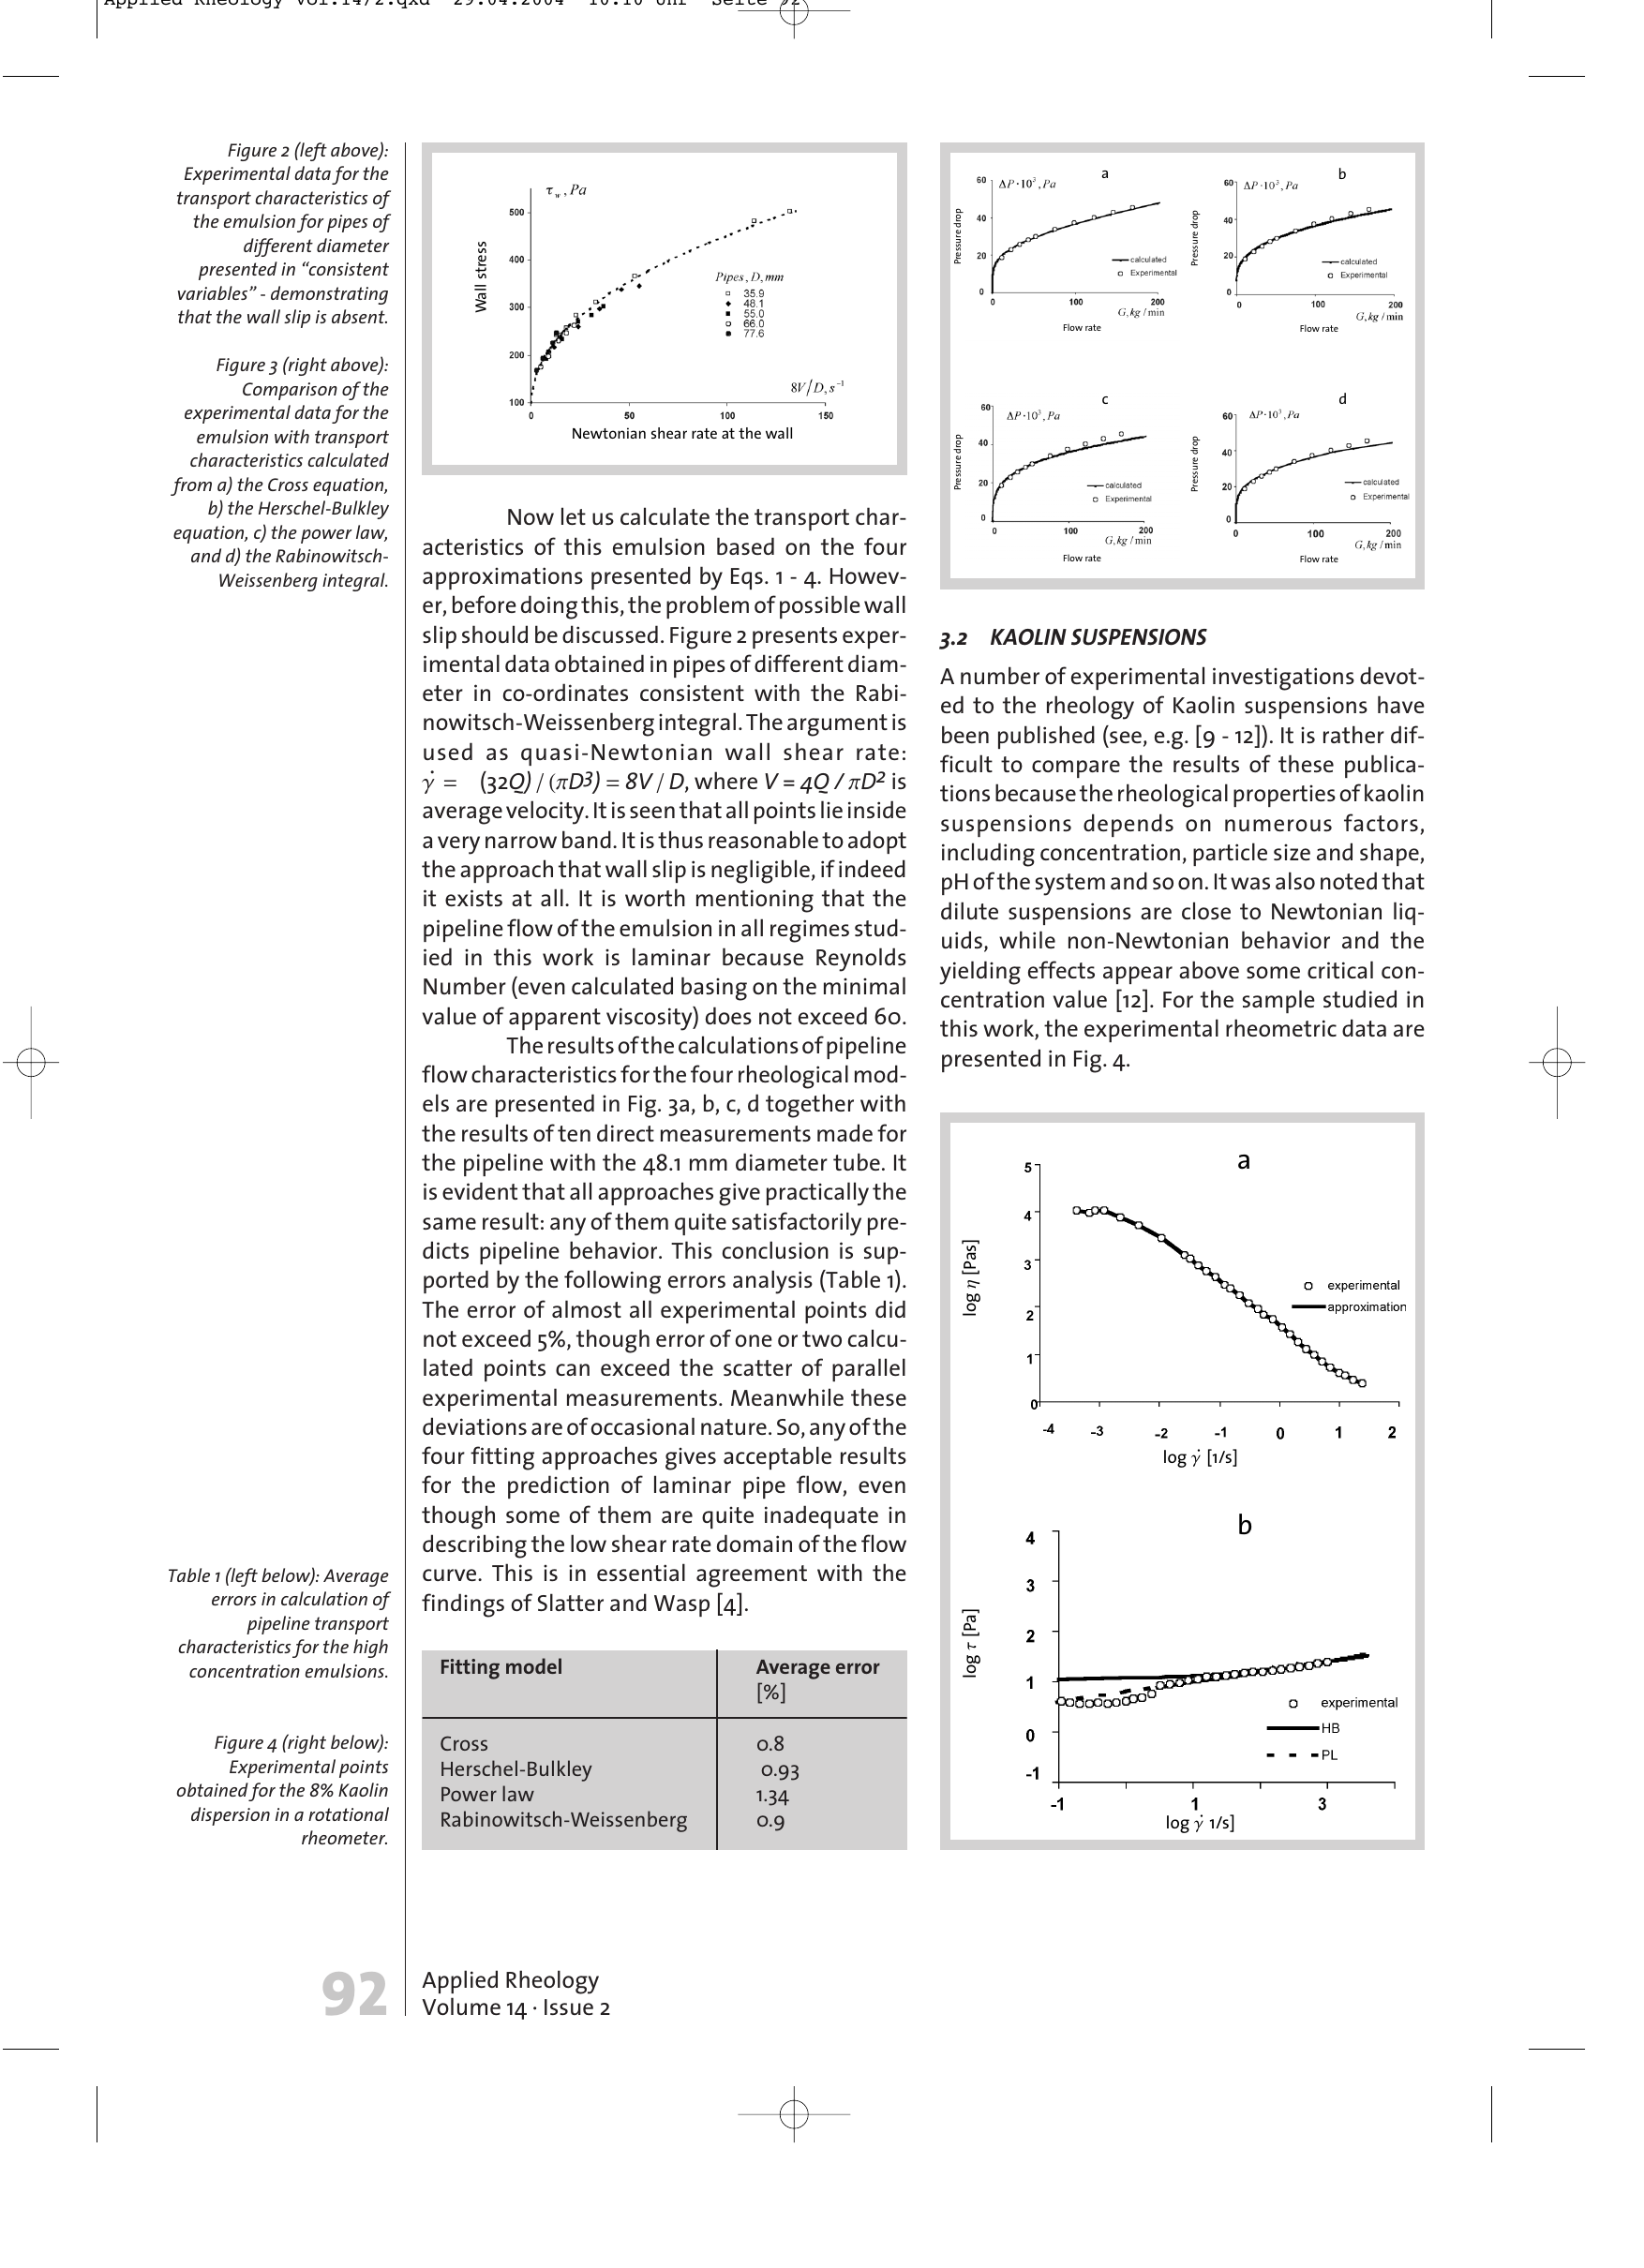
r s t ll W a Newtonian shear rate at the wall